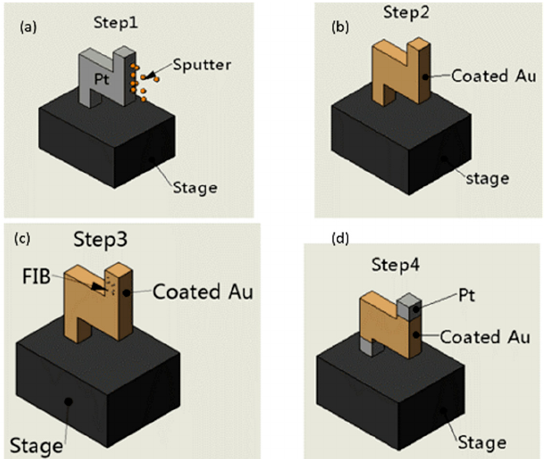
Figure 2. The mechanism of sputtering deposition. ( a ) Gold was coated on the nanorobot via a sputtering machine. ( b ) The nanorobot was fully coated with gold. ( c ) The nanorobot was etched by the FIB. ( d ) The structure of the Z-shaped nanorobot.